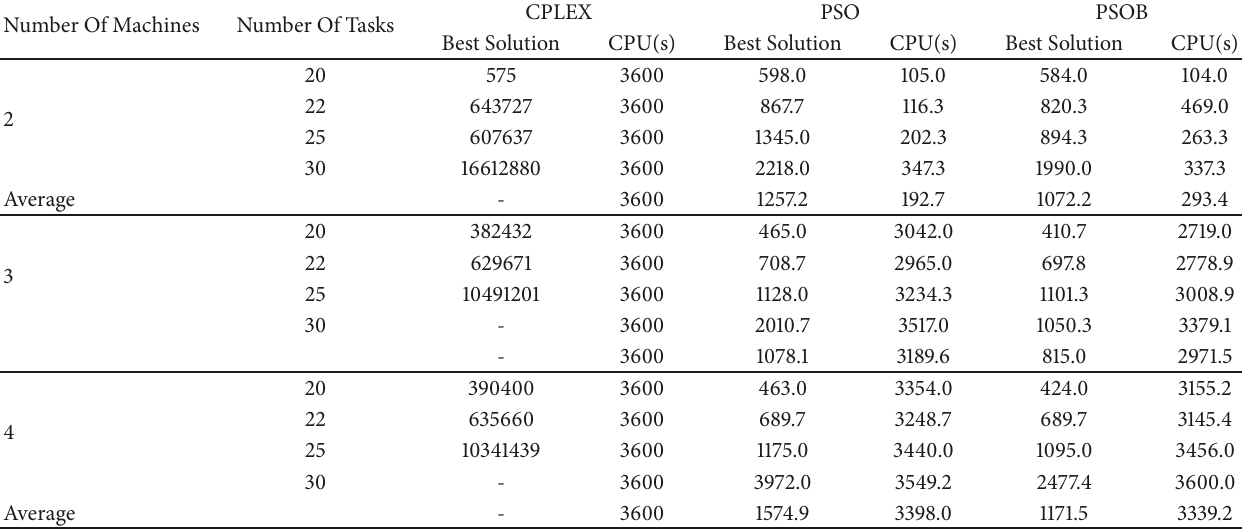
Table 6: Computational experiments of solving large-scale instances by CPLEX, PSO, and PSOB algorithms. Number Of